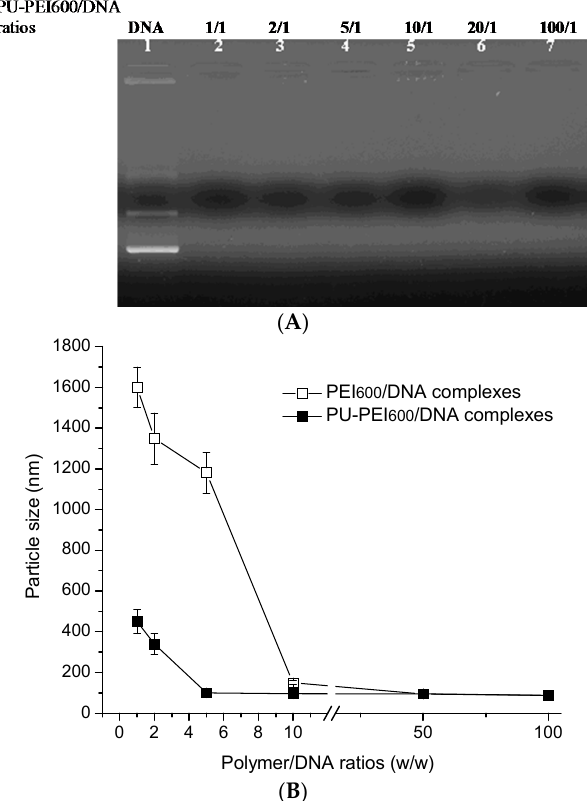
Figure 1. ( A ) DNA gel retardation of PU-PEI 600 /DNA complexes at various ratios ( w / w ); lanes 1, free DNA; lane 2, PU-PEI 600 /DNA = 1/1; lane 3, PU-PEI 600 /DNA = 2/1; lane 4, PU-PEI 600 /DNA = 5/1; lane 5, PU-PEI 600 /DNA = 10/1; lane 6, PU-PEI 600 /DNA = 20/1; lane 7, PU-PEI 600 /DNA = 100/1; ( B ) Particle sizes of polymer/DNA complexes prepared at various ratios ( w / w ). Data are presented as mean ± SD ( n = 3).